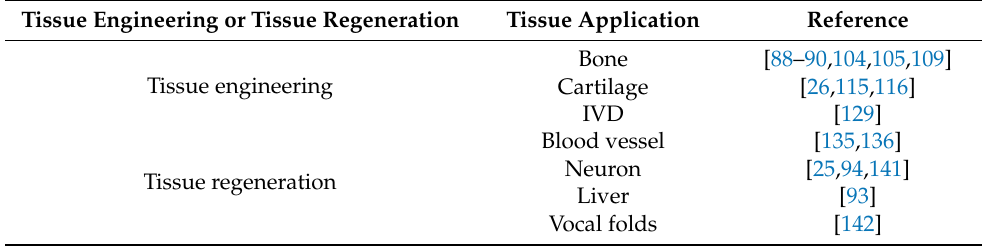
Table 3. Summary of CAC as a scaffold in tissue engineering and tissue